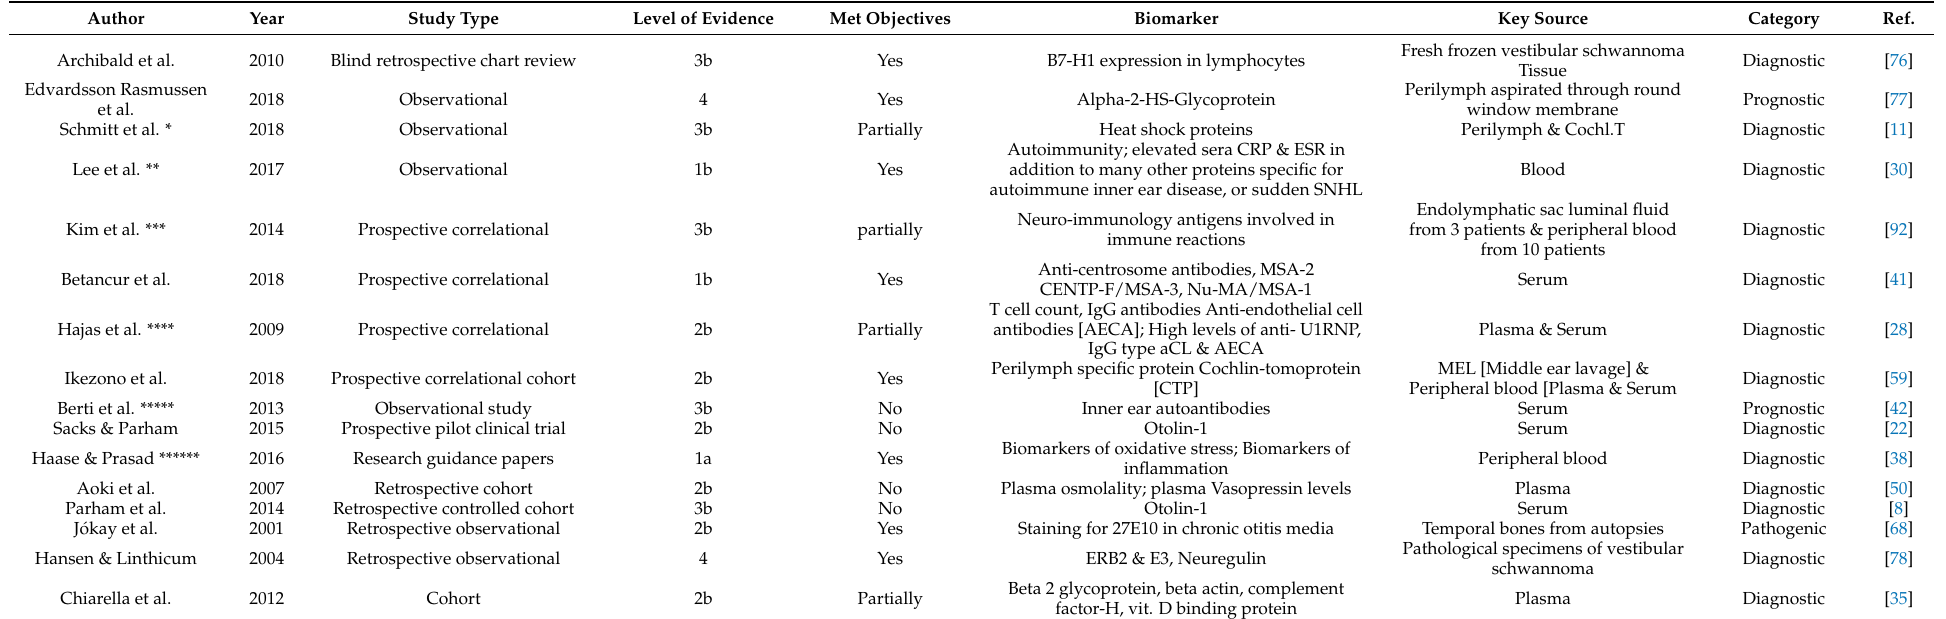
Table 1. Molecular biomarkers related to the inner ear in